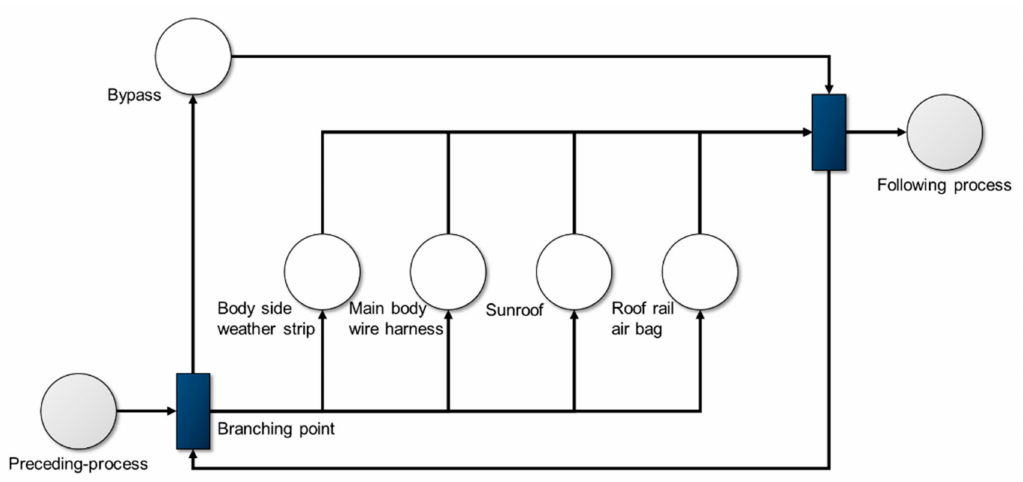
Figure 2. Schematic of re-entrant production